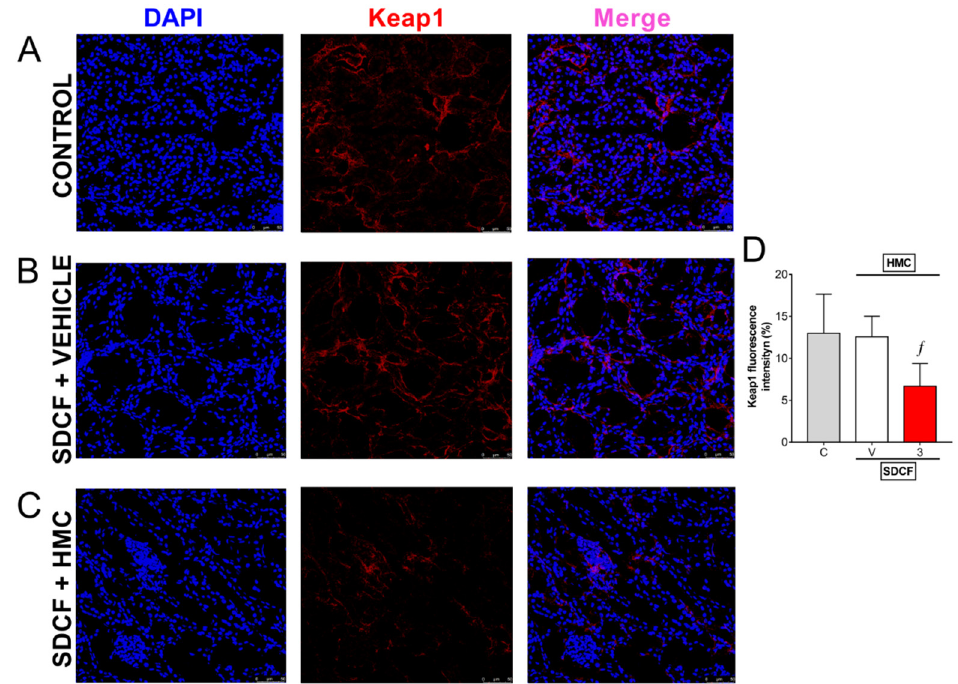
Figure 8. HMC reduces Keap1 protein expression in renal tissue. Kidney samples were collected 24 h after the administration of SDCF for the evaluation of immunofluorescence detection of Keap1 ( A – D ). Original magnification 40×; 50 μ m scale. DAPI was used for nuclear detection in samples. Data are showed as mean ± SD, n = 5 mice per group per experiment, and are representative of two independent experiments. f p < 0.05 vs. control (C) and SDFC + vehicle treated (V) groups; one ANOVA followed by Tukey’s post hoc